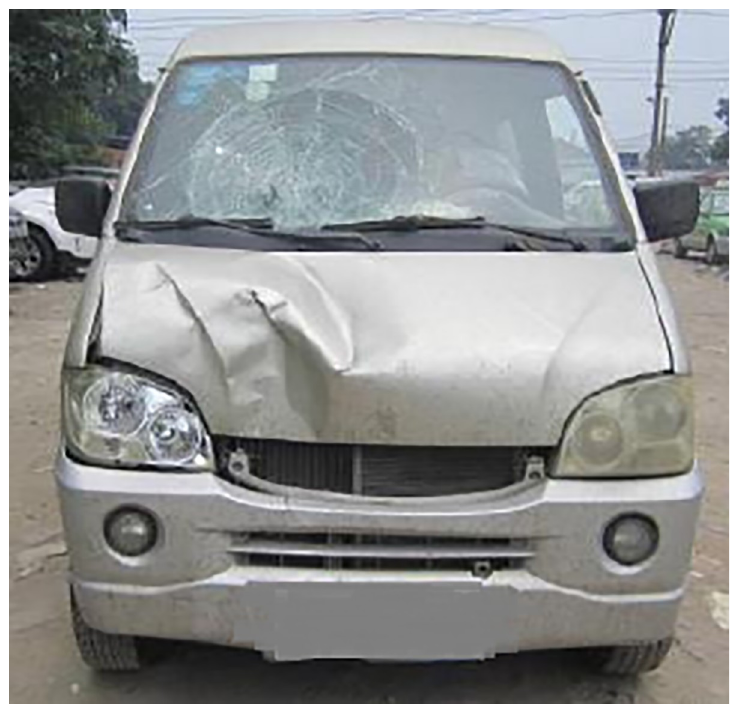
Fig 2. Damage of